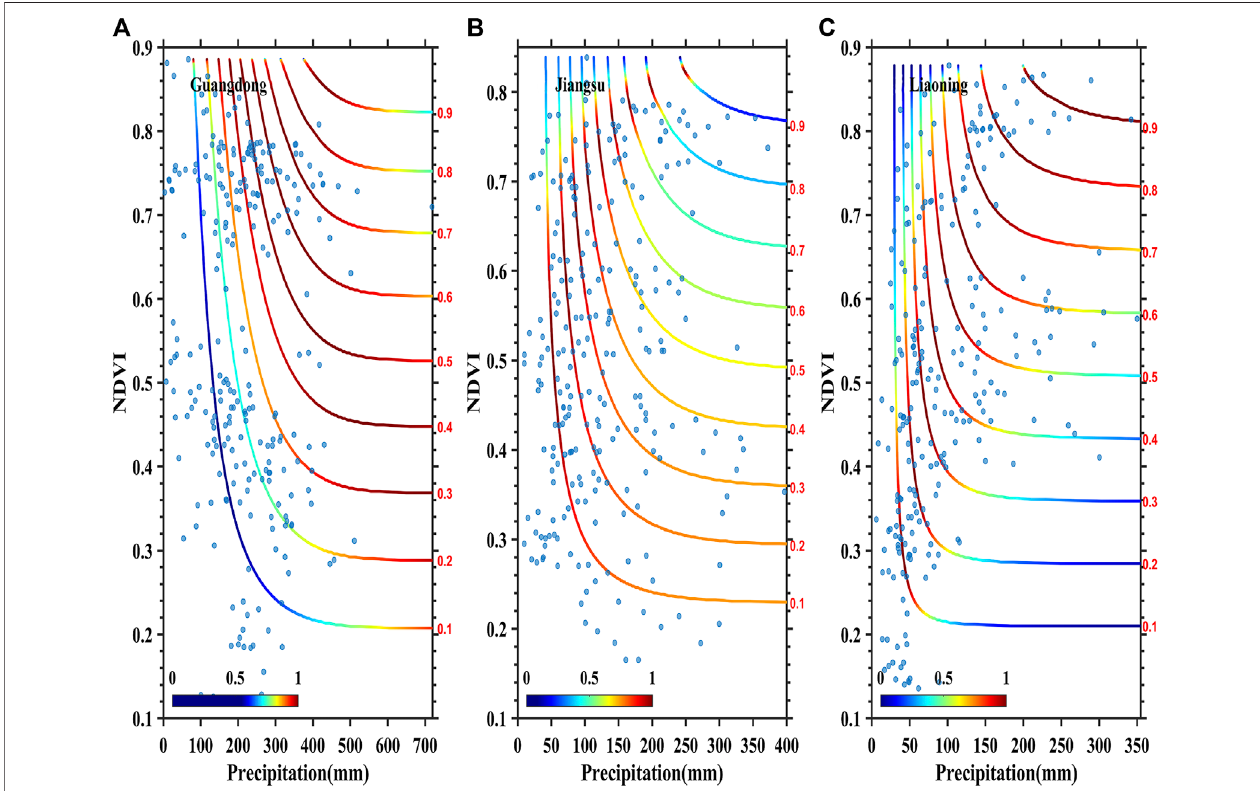
FIGURE 7 | Joint copulas of precipitation-normalized difference vegetation index (NDVI) in (A) Guangdong, (B) Jiangsu, and (C) Liaoning.